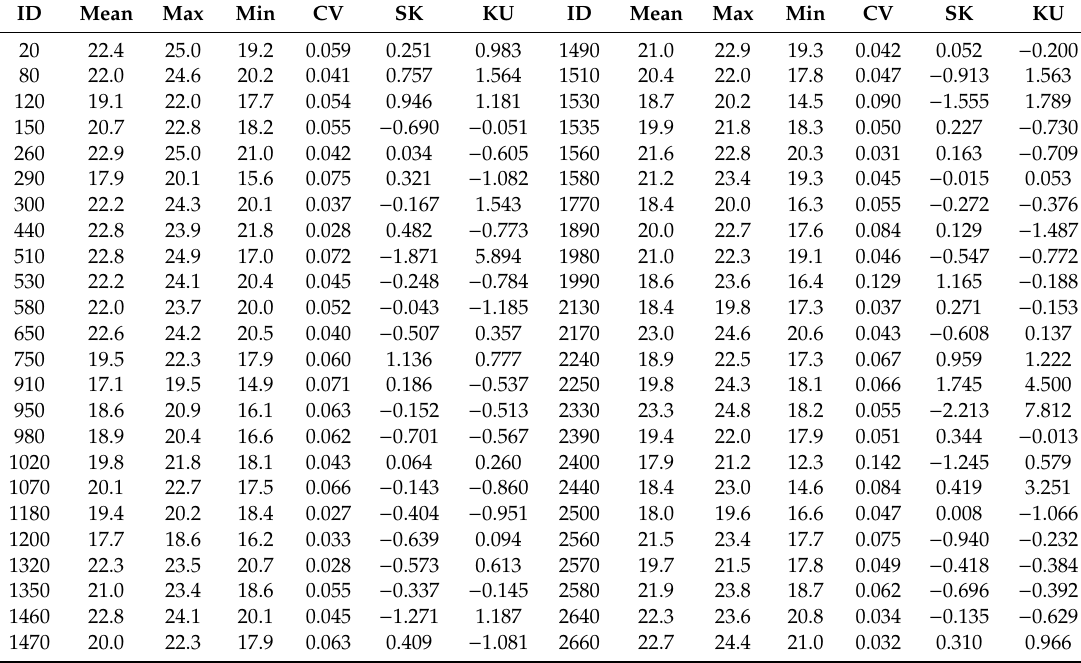
Table 2. Main statistics of the maximum temperature